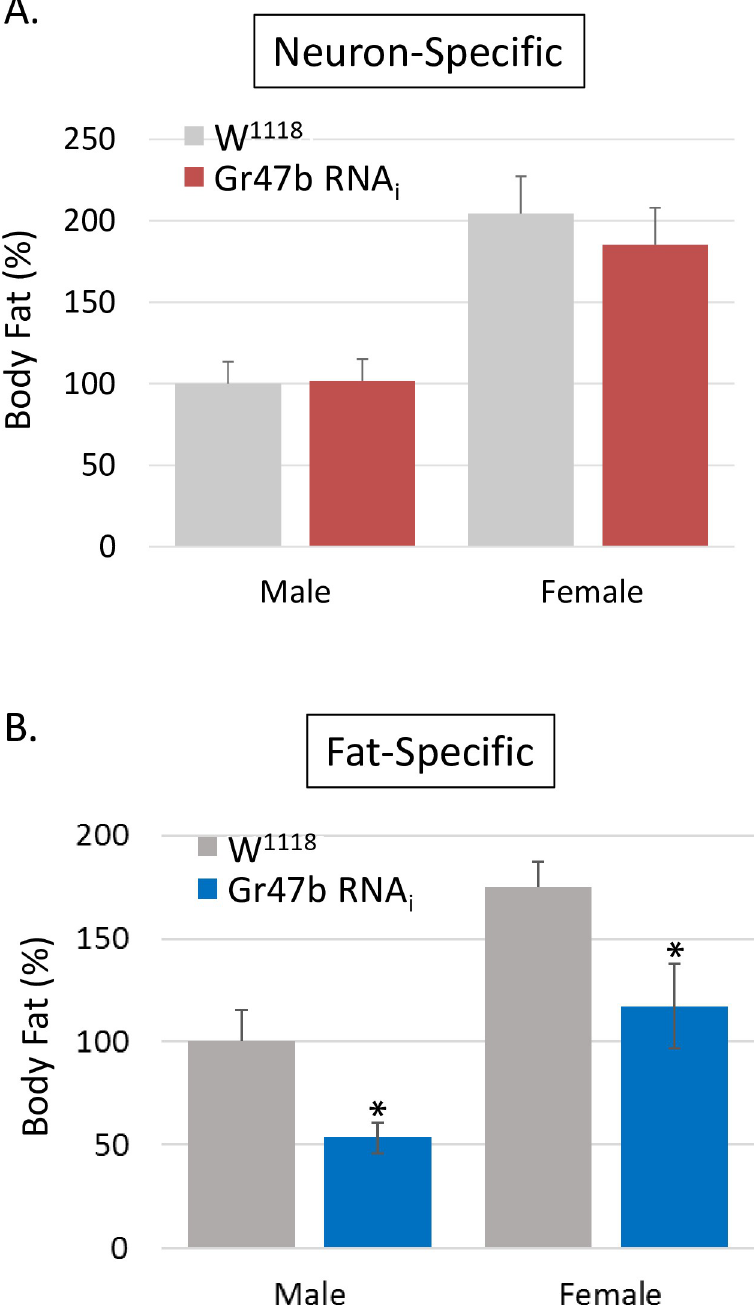
Fig 6. Adipose-specific knocking-down of Gr47b significantly reduced the amount of body fat. (A) Gr47b RNAi males were mated with nSyb-Gal4 females. The resulting F1 adults were collected, sorted by sex, homogenized, and used to determine body fat. The control adults were generated from the cross between W 1118 and nSyb-Gal4. Relative Body Fat (%) = (TG miRNA /TG control ) X 100. Error bars represent the standard deviation. (B) Gr47b RNAi males were mated with fat-specific Dcg-Gal4 females. The resulting F1 adults were analyzed together with their controls. Statistical analysis was performed by Student’s T-test. � : P < 0.01.